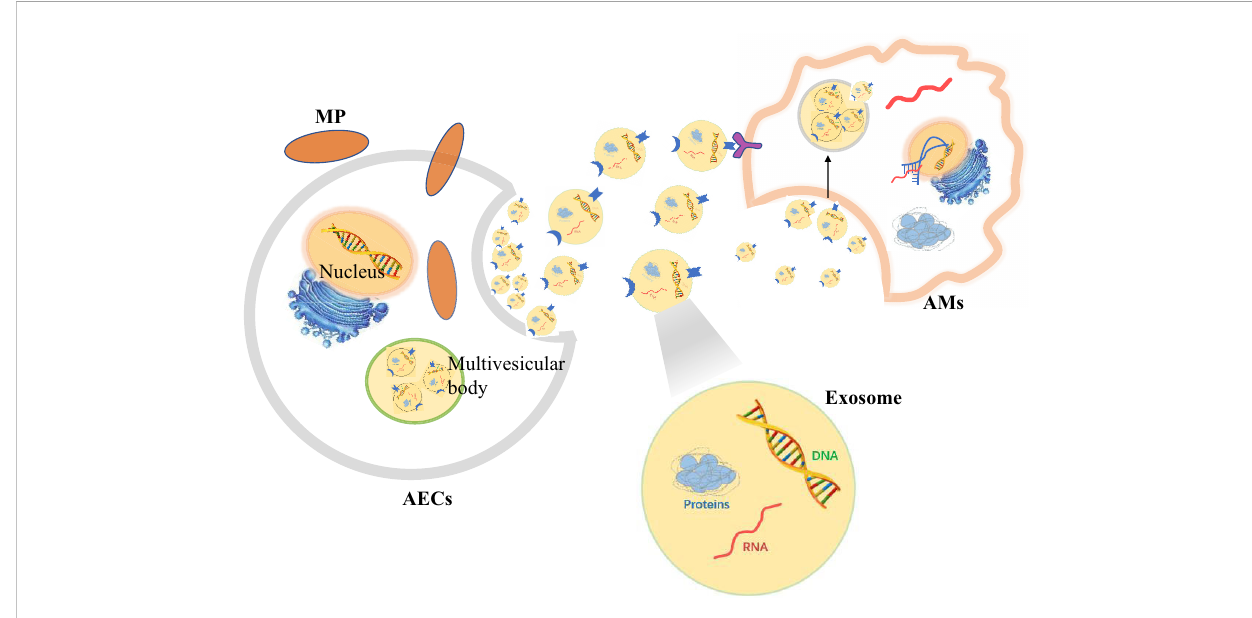
FIGURE 3 Alveolar epithelial cells (AECs) contact alveolar macrophages (AMs) to resist Mycoplasma pneumoniae (MP) by secreting